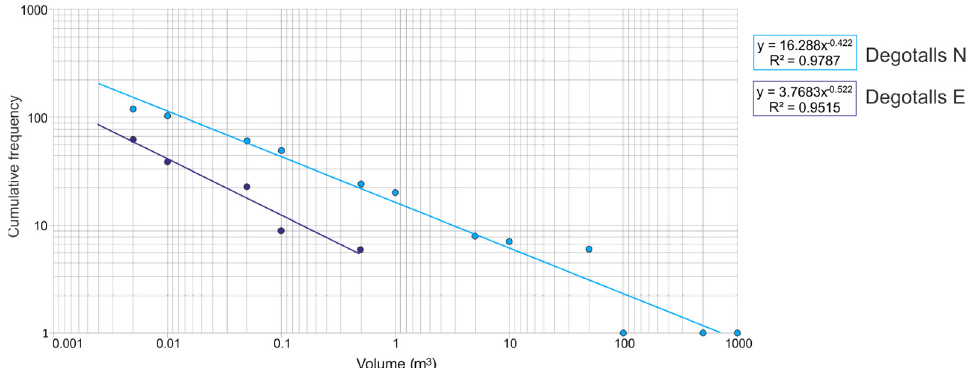
Figure 12. Cumulative frequency–rockfalls volume in both Degotalls cliffs. The power law functions are depicted on the upper left for each scenario. The values of volume are grouped into intervals.